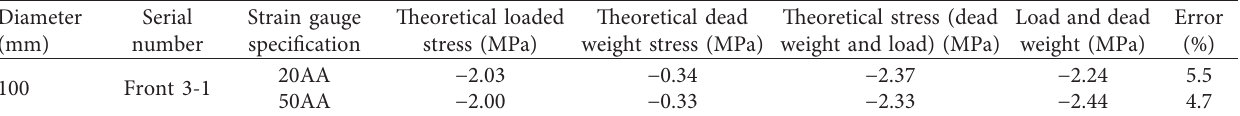
Table 6: Comparison of numerical and experimental in situ stress results for the concrete of the first beam. Table 7: Comparison of numerical and experimental in situ stress results for the concrete of the second beam. Diameter (mm) Front 2-1 50 Table 8: Comparison of numerical and experimental in situ stress results for the concrete of the third beam. Diameter